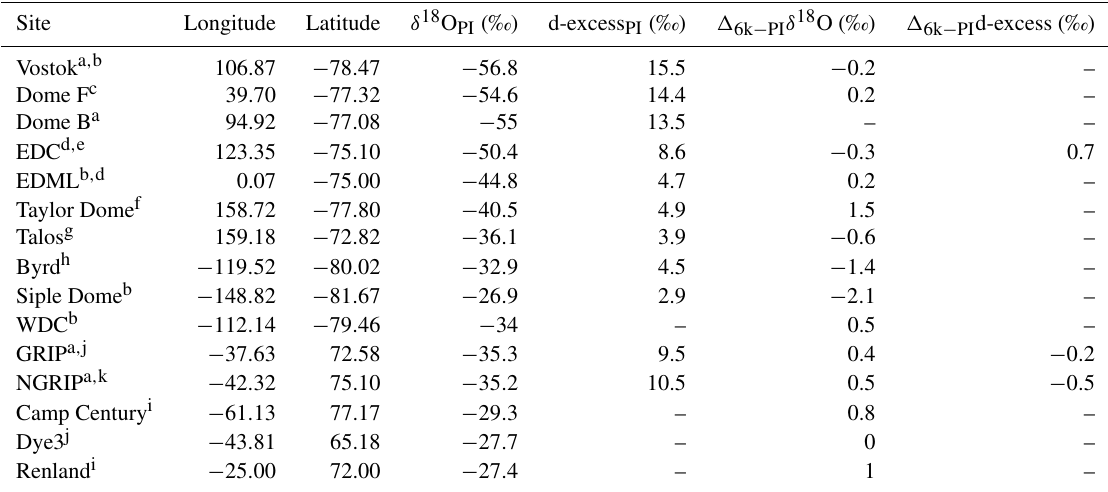
Table 1. Selected ice core records and their geographical coordinates, reported PI values of δ 18 O and d-excess, and changes in δ 18 O and d-excess between 6k and PI. All values are given with respect to the V-SMOW